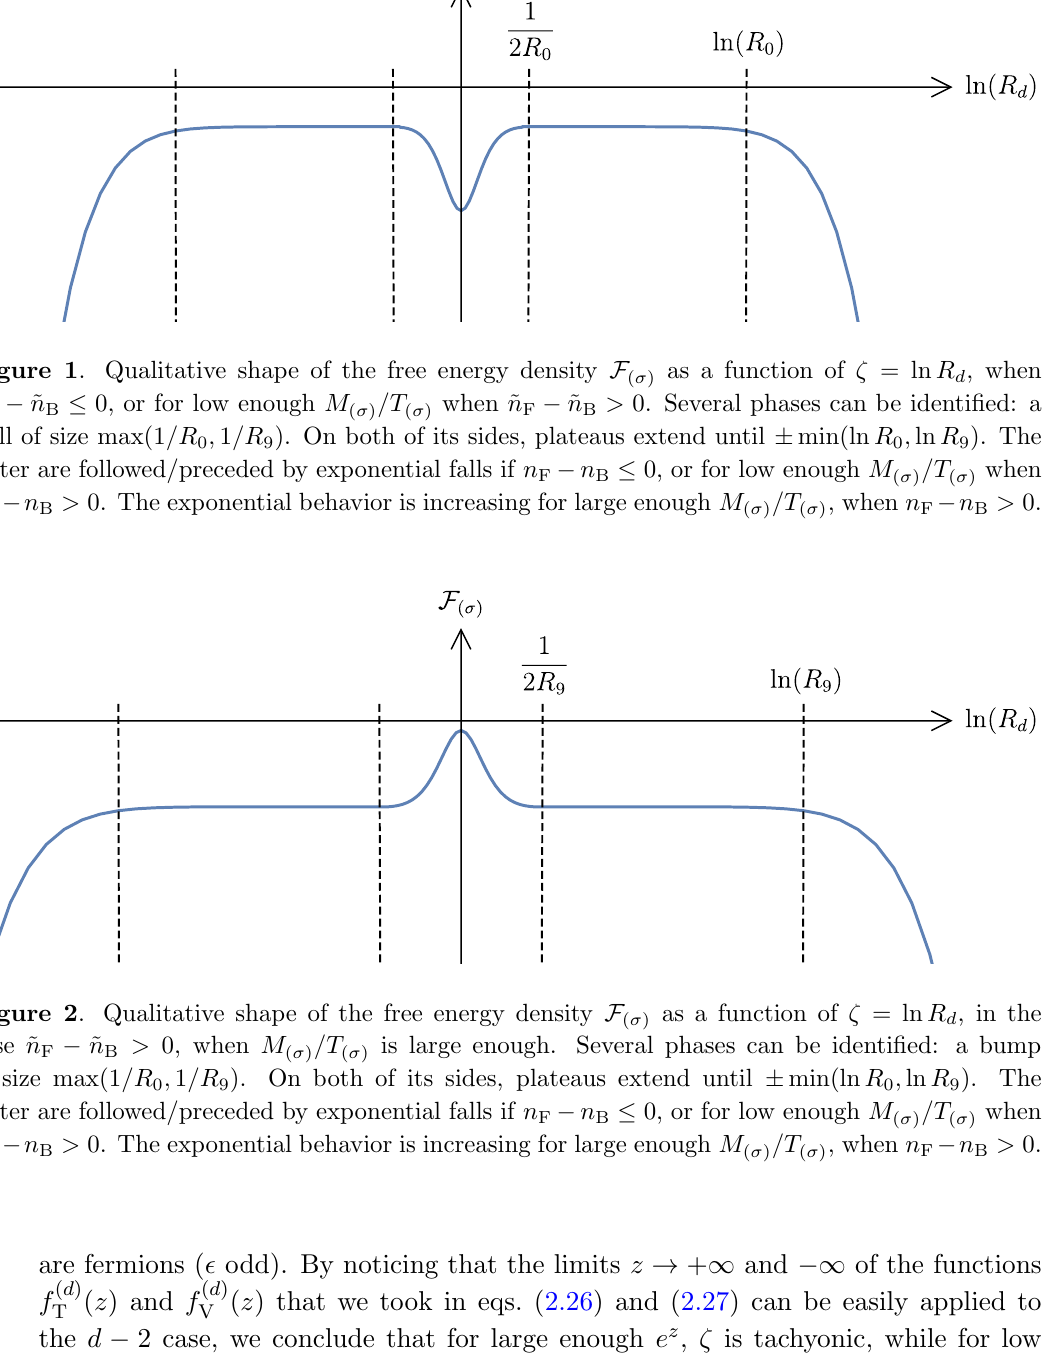
are fermions ( (cid:15) odd). By noticing that the limits z ! + 1 and (cid:0)1 of the